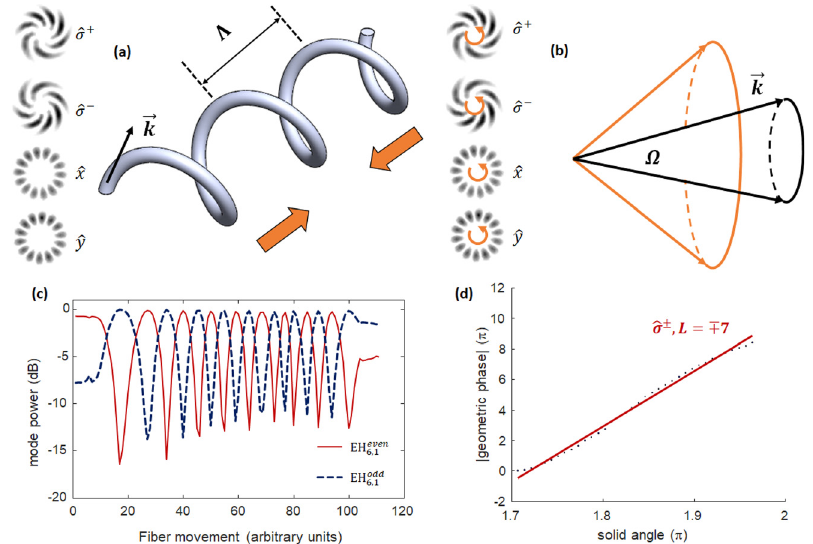
Figure 6: Systematic control of Pancharatnam – Berry phases in optical fibers. (a) An orbital angular momentum (OAM) mode supporting ring-core fiber, inserted in a loose Teflon tube, is attached to a flexible spring to configureahelicalwithvariableperiod Λ .AcombinationoftwodegenerateOAMmodes( L (cid:1) − 7 (cid:6) σ + and L (cid:1) + 7 (cid:6) σ − )islaunchedintothe fi ber.For visual clarity, the OAM modes are illustrated with spiral patterns that arise from their interference with an expanded Gaussian beam. The corresponding projection of this superposition state into (cid:6) x and (cid:6) y polarization-bins yields petal patterns, illustrated at the bottom left hand side of (a). The mode illustrations on the right side of the helical arrangement show the corresponding modes at the output of the fi ber, all of which are rotated counterclockwise due to the geometrical transformation; (b) Geometric illustration of the solid angle Ω enclosed by the k -vector of the light path in this helical arrangement. The illustration in orange depicts the higher Ω obtained from compressing a spring from its original state, depicted in the black illustration; (c) Measured power fl uctuations between even and odd modes for EH 61 , using the reciprocalmodetransmissionsetupofFigure5(a),whenthespringwascompressed(pitchperiod Λ decreasesfrom2.3to0.2cm).Theuneven periodicity results from the uneven speed with which the spring was compressed; (d) Geometric phase, measured from vector mode power ratios,versussolidangle,fortwodegenerateOAMmodes L (cid:1) − 7 (cid:6) σ + and L (cid:1) + 7 (cid:6) σ − asthehelicalspringiscompressed.Theredlineisalinear fi t of the experimental data (solid circles). Near-linear relationship shows exclusive in fl uence of fi ber path on geometric phase, and hence relative mode